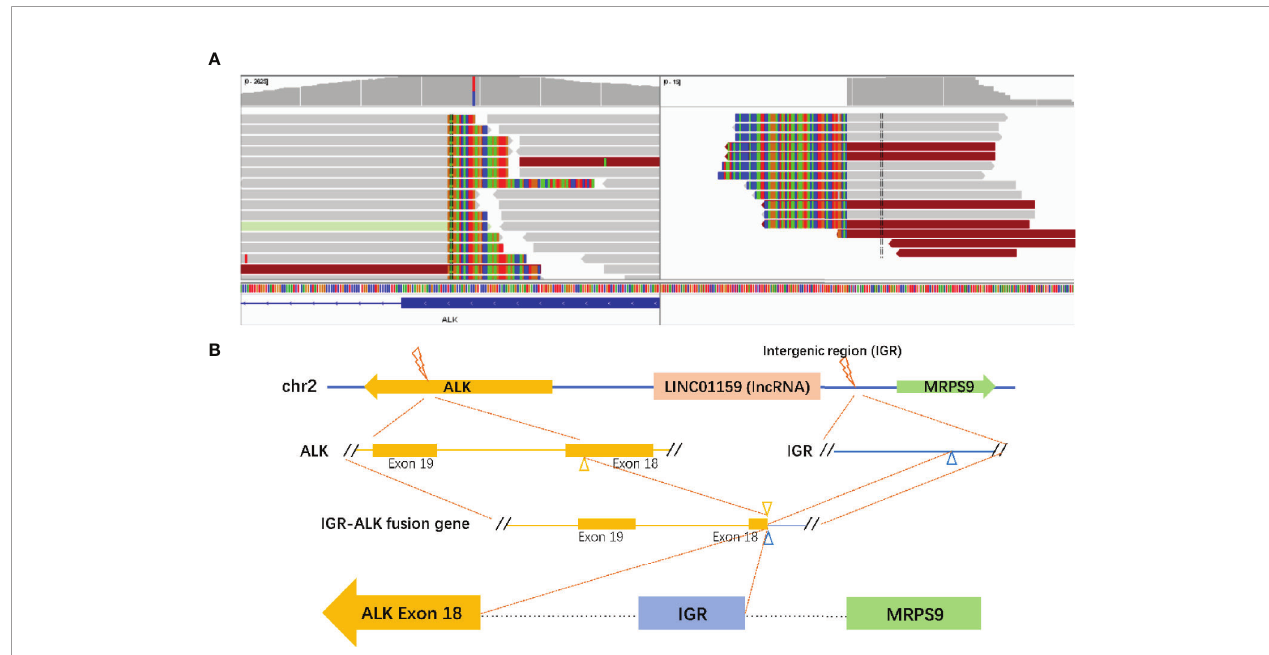
FIGURE 3 | Identi fi cation of the MRPS9-ALK fusion. (A) Sequencing reads of ALK and LINCO1159 & MRPS9 were visualized using the Integrative Genomics Viewer (IGV). (B) The structure schematic map of the MRPS9-ALK fusion locus. Intergenic region (IGR) of LINCO1159 & MRPS9 were fused to exon 18 of the ALK